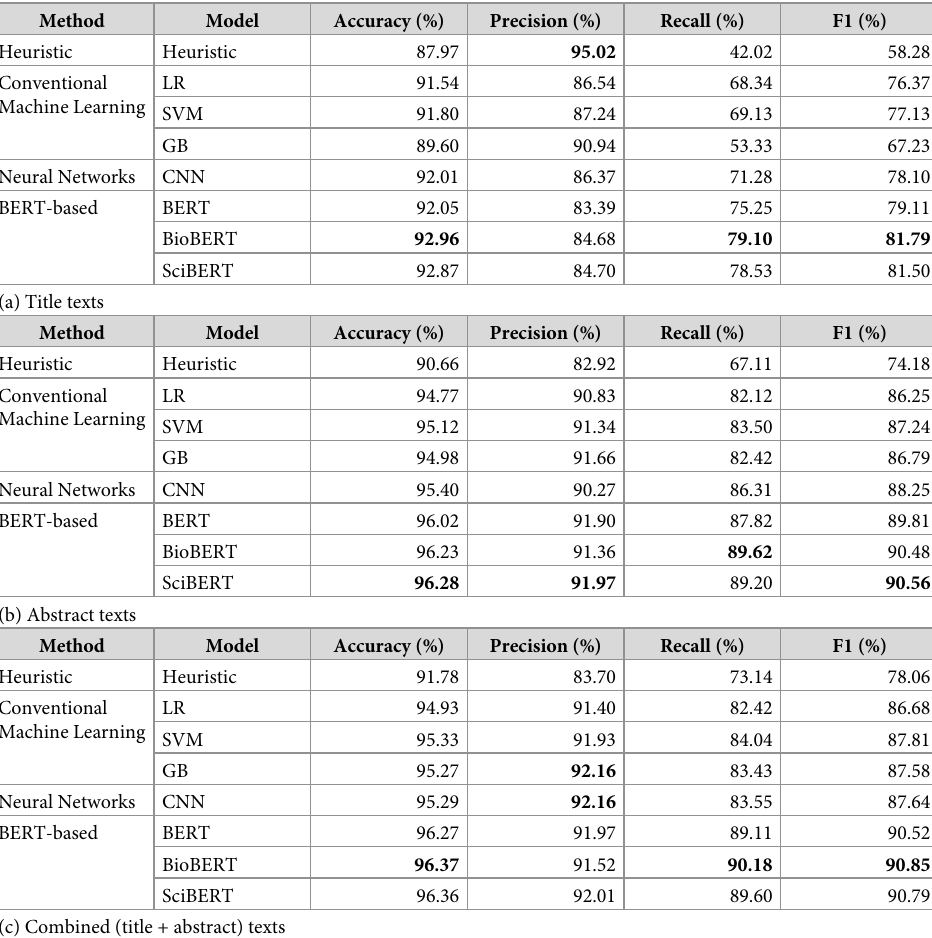
Table 3. Summary of evaluation results of a heuristic model, three conventional machine learning models (LR, SVM, and GB), a neural networks model (CNN), and three BERT-based models (BERT, BioBERT, and SciBERT) for using (a) title, (b) abstract, and (c) combined title and abstract as input data. Bold indicates the best perfor- mance results among all models. LR: Logistic Regression, SVM: Support Vector Machines, GB: Gradient Boosting, CNN: Convolutional Neural